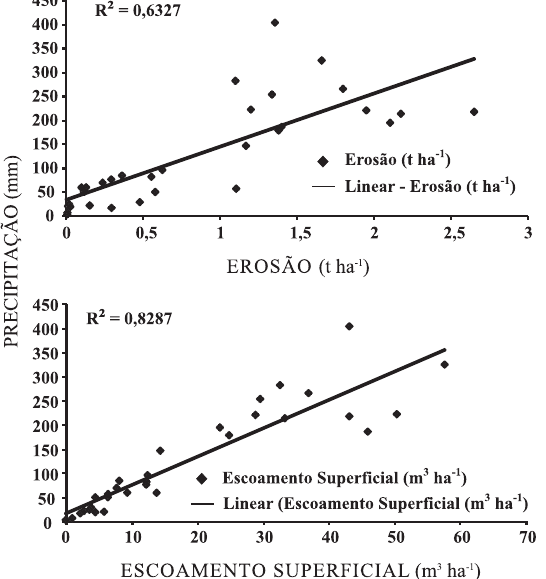
Figura 3. Relação entre as precipitações, perdas de solo e escoamento superficial no tratamento sob cultivo de banana.